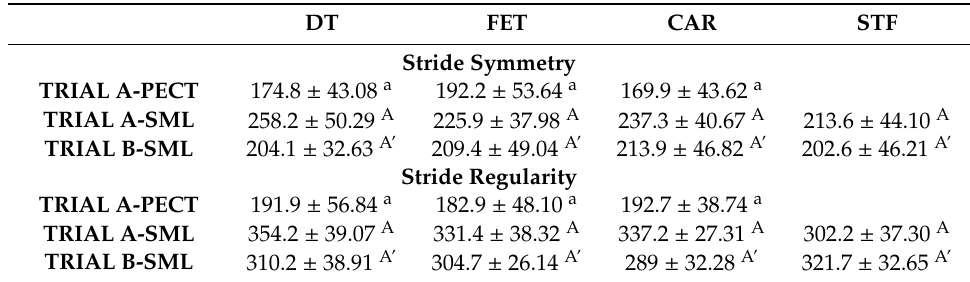
Table 2. Means and standard deviation of stride symmetry and regularity in horses exercised on a water treadmill at di ff erent water depths and